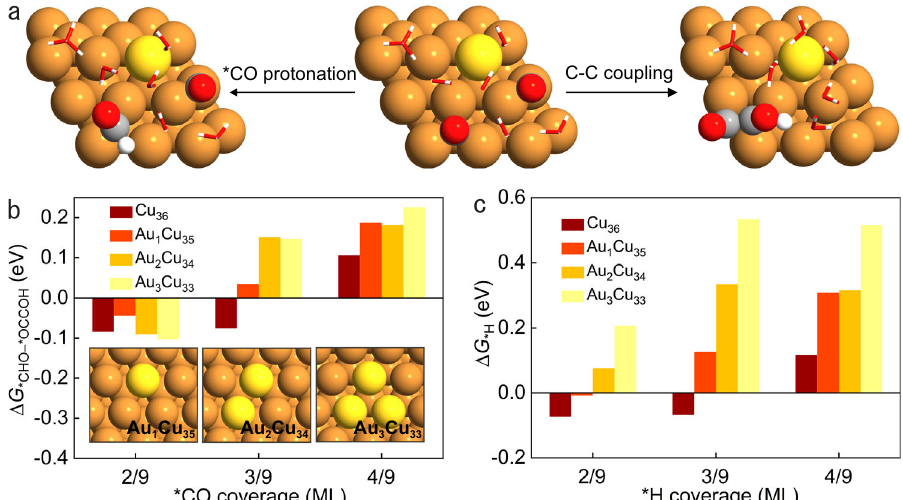
Fig. 1 DFT studies. a Geometries of *CO, *CHO, and *OCCOH intermediates on Au – Cu surface, showing the competitive steps of *CO protonation and C – C coupling. b Reaction free energy difference between *CO protonation and C – C coupling steps on Cu 36 , Au 1 Cu 35 , Au 2 Cu 34 , and Au 3 Cu 33 surfaces under varying *CO coverages. c Reaction free energies for *H intermediate formation under varying *H coverages on Cu 36 , Au 1 Cu 35 , Au 2 Cu 34 , and Au 3 Cu 33 surfaces. Cu, Au, C, O, and H atoms in Fig. 1 are illustrated as orange, yellow, grey, red, and white spheres, respectively, while the water molecules are shown as sticks. Source data are provided as a Source Data fi